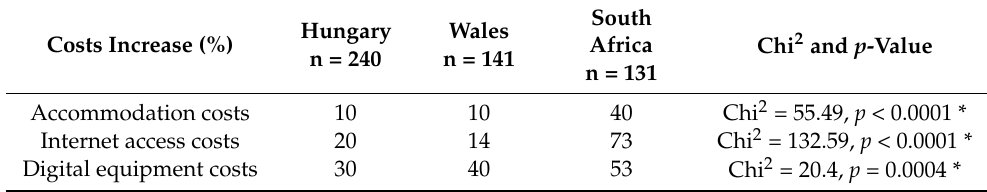
Table 1. The impact of the pandemic on learning costs.